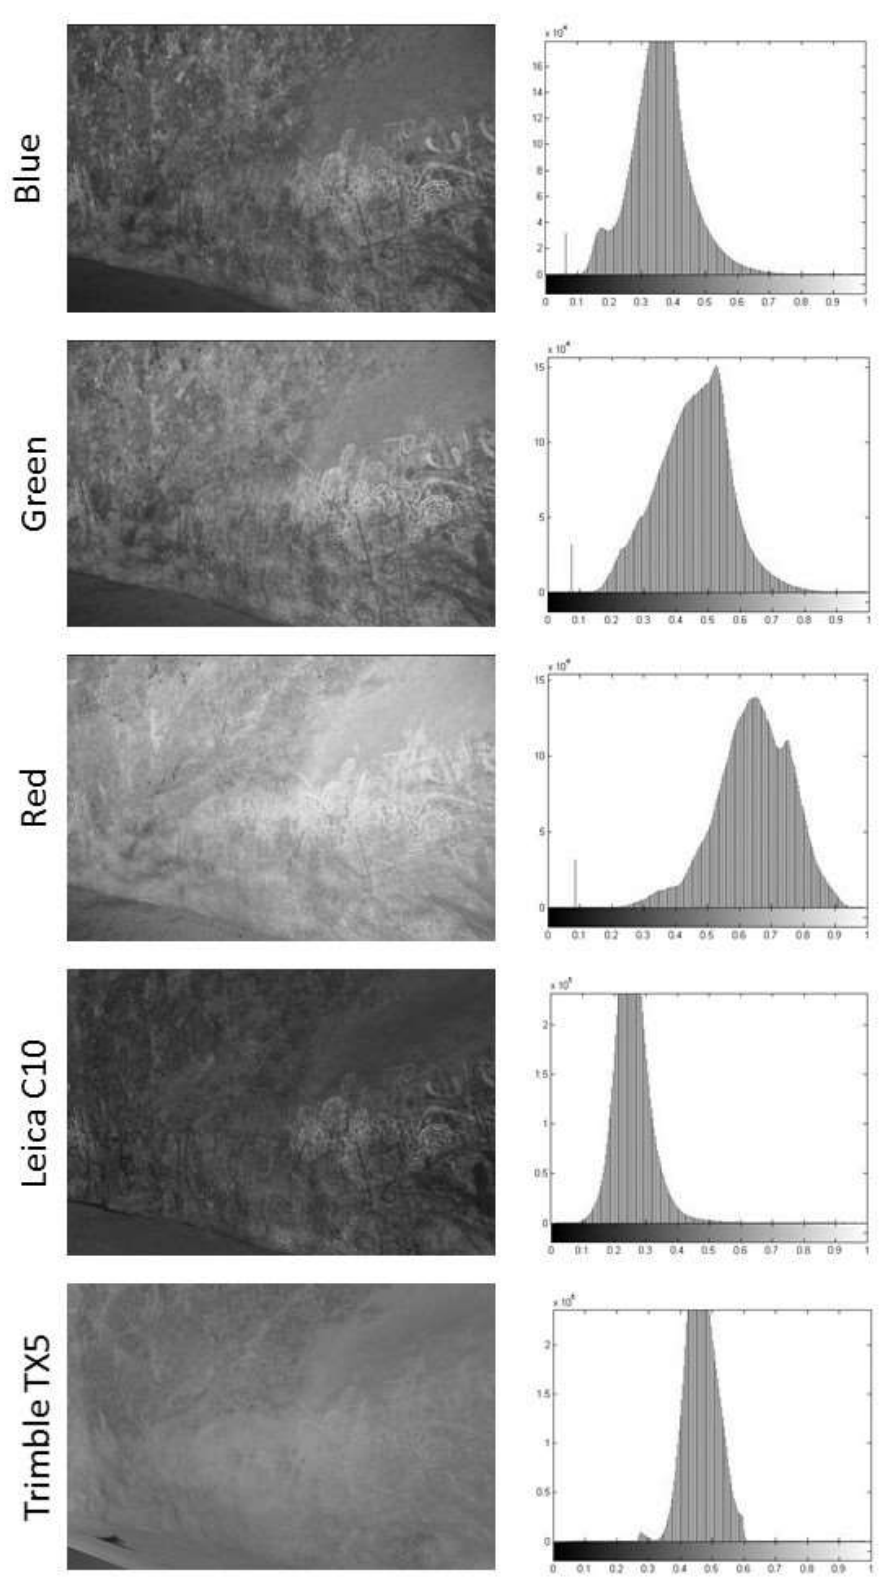
Figure 2: Images of the different bands with the corresponding normalised intensity histograms (histograms are normalised to range from 0 to